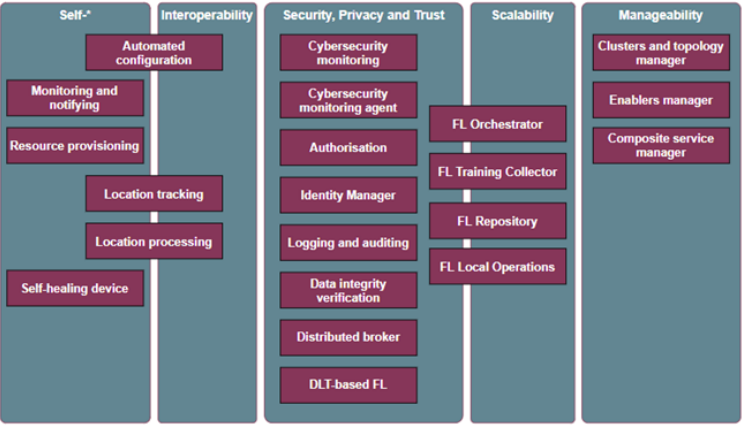
Figure 3. ASSIST-IoT functional